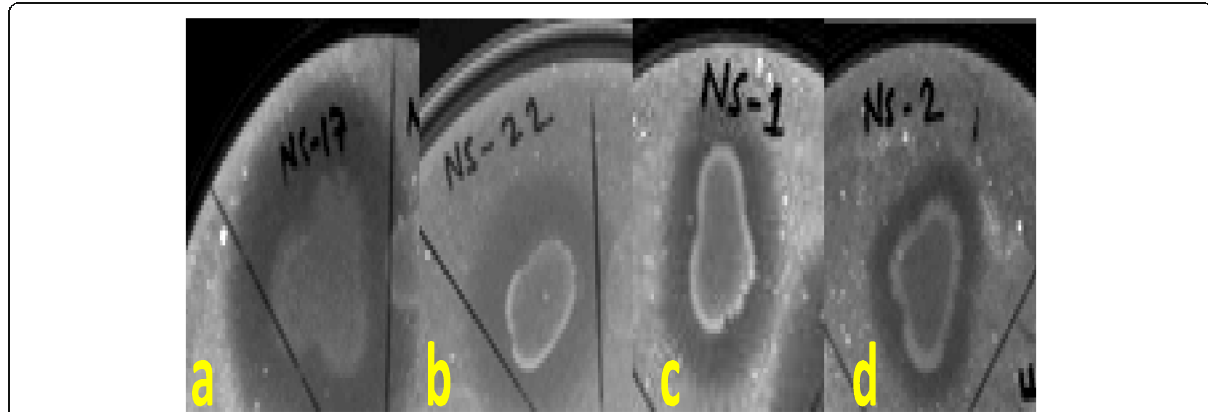
Fig. 1 Clear zone of chitin hydrolysis produced on 1% CCA plate by the bacterial isolates obtained from pigeon pea rhizosphere. a Chitin hydrolysis zone formed by isolate NS-17. b Chitin hydrolysis zone formed by isolate NS-22. c Chitin hydrolysis zone formed by isolate NS-1. d Chitin hydrolysis zone formed by isolate NS-2 (representative images of few isolates)